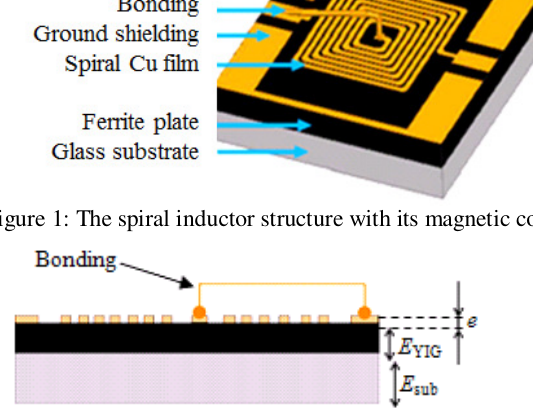
Figure 2: Cross section of the spiral inductor structure.